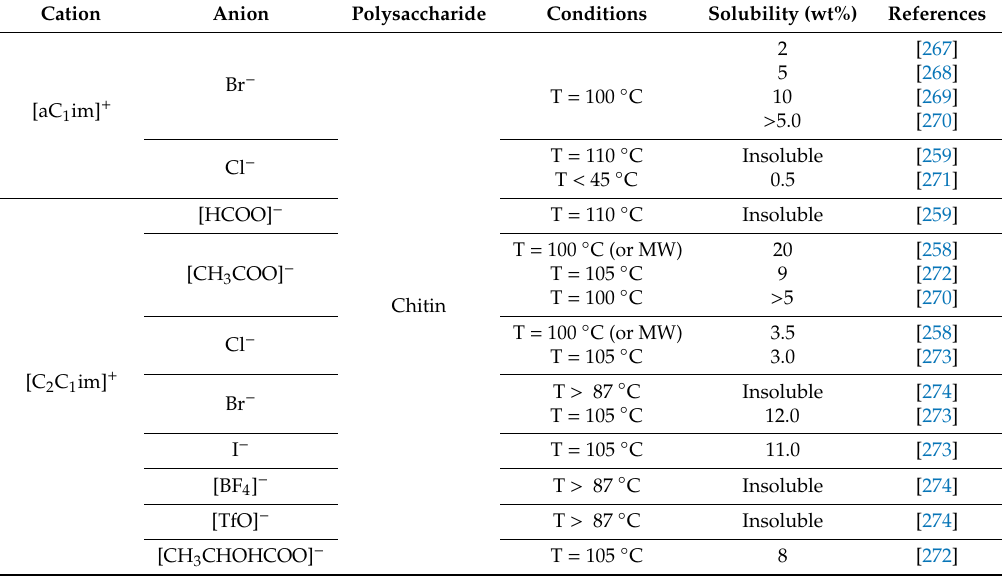
Table 10. ILs reported to dissolve chitin and chitosan, their solubility and conditions applied.